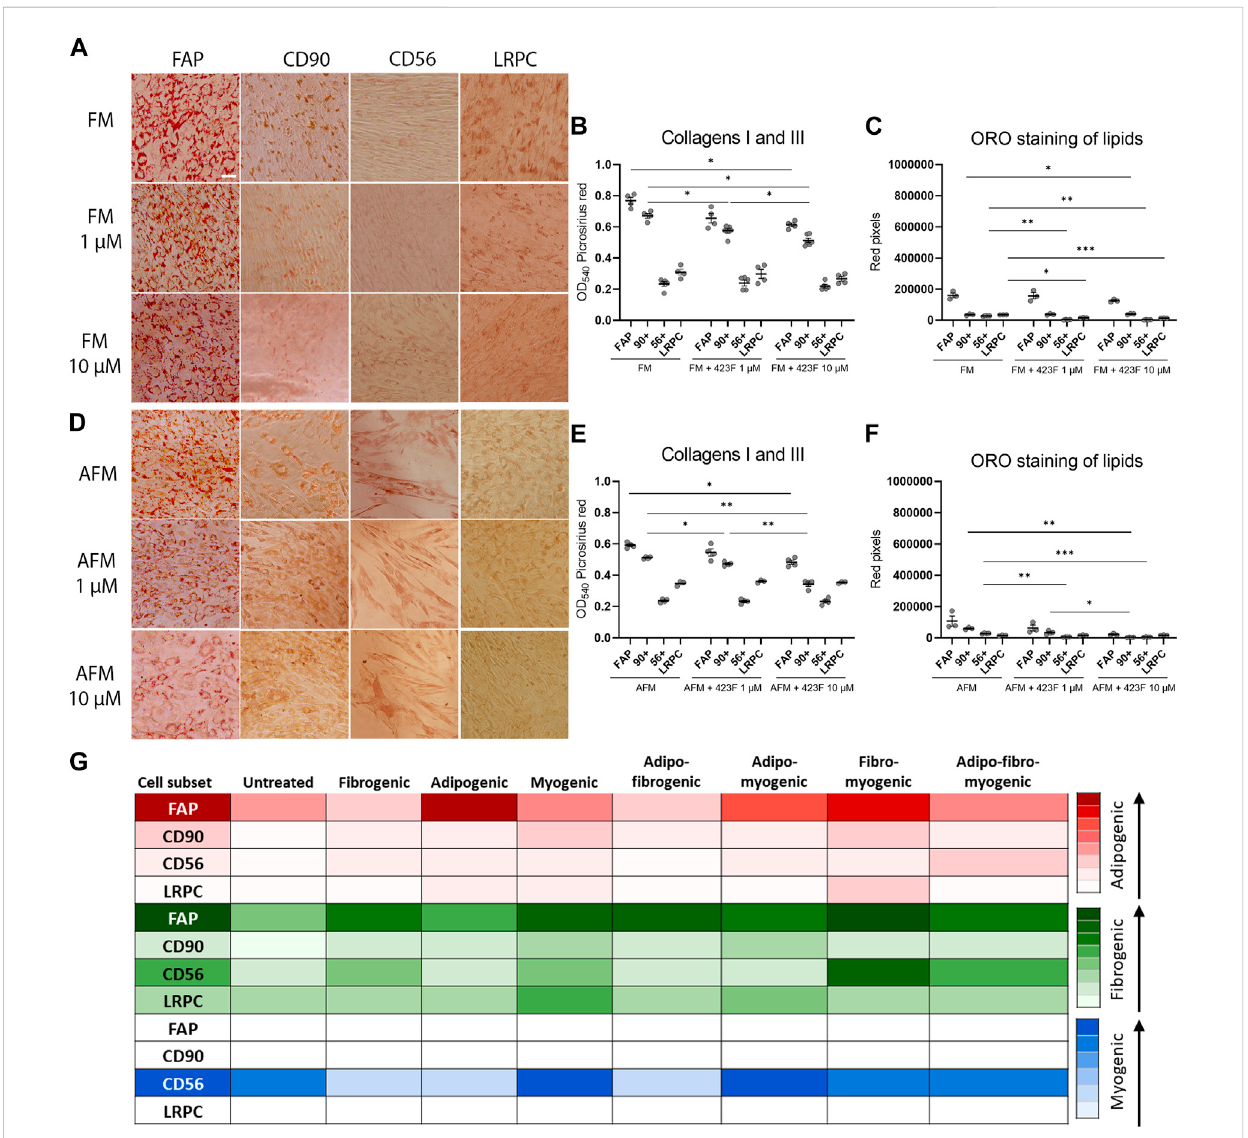
FIGURE 6 423F elicits greater inhibition of human muscle FAP fi bro-adipogenic differentiation than that of CD56, CD90 and LRPC in fi bro-myogenic and adipo- fi bro-myogenic cultures. Representative images of Oil Red O-stained adipogenic cells in fi bro-myogenic (A) and adipo- fi bro-myogenic cultures (B) for each cell subset. Picrosirius red spectrophotometric quanti fi cation of collagen production (B, E) and red pixel quanti fi cation of Oil red O-stained adipocytes (C, F) at the indicated conditions in the presence or absence of 1 and 10 µM 423F. Data (mean ± SEM) was pooled from multiple experiments with triplicates for all cultures (n = at least 3 per cell subset). Data was analyzed via paired one-way ANOVA and Tukey ’ s post hoc multiple comparisons, *** p < 0.001, ** p < 0.01, * p < 0.05. (G) Color scale denotes the degree of subset differentiation. Scale bar represents 100 μ